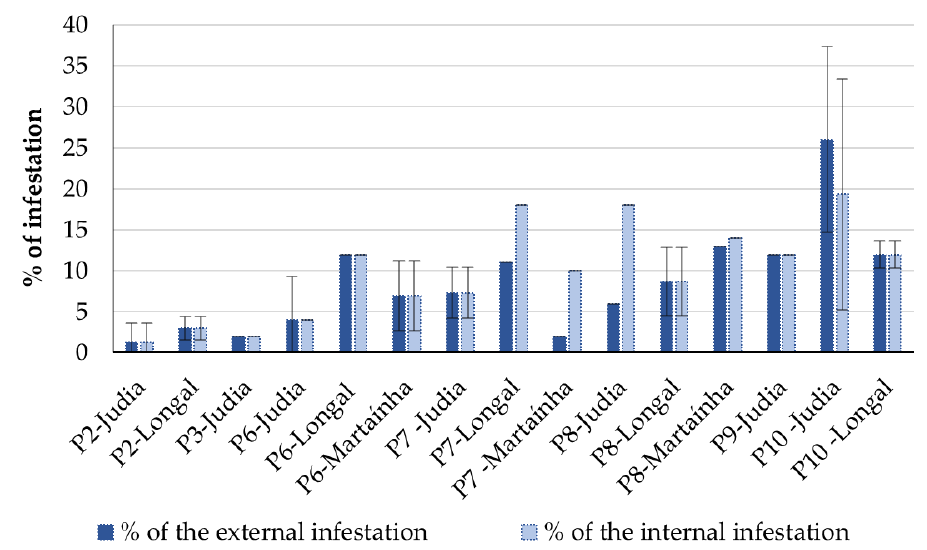
Figure 2. Percentage of external and internal infestation at different processing stages for the varieties Longal, Judia and Martaínha (mean ± SD; n = 50). P2, P3 — sterilized chestnuts (0 and 15 days storage); P6 — unsterilized chestnuts in reception; P7, P8, P9 — unsterilized chestnuts after storage (15, 30 and 45 days, respectively); P10 — sterilized chestnuts rejected by sorting.